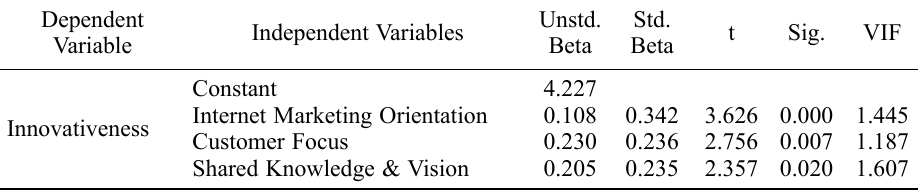
Table 1. Regression analysis – the influence of market orientation, learning orientation and Internet marketing orientation on innovation capabilities